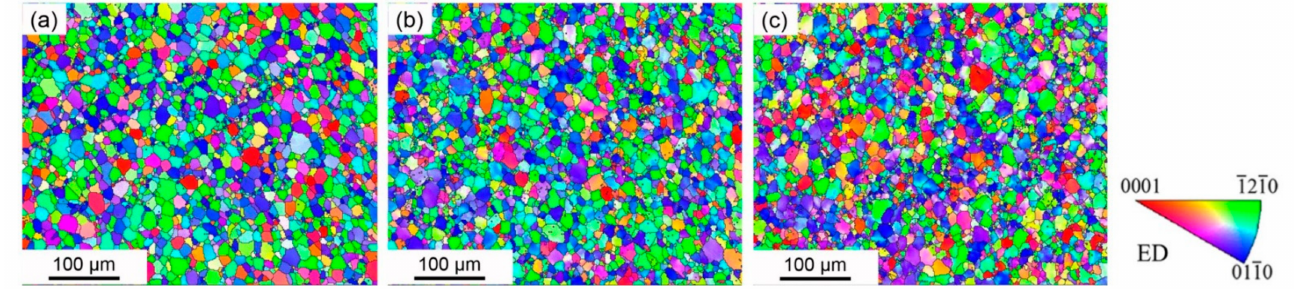
Figure 1. Inverse pole figures of the twisted samples in the edge region ( a ) PT8, ( b ) PT28, ( c ) PT51. (cid:0) (cid:1) (cid:0) (cid:1) The pole figures corresponding to ( 0001 ) , 1010 , 1011 planes are shown in Figure 2. It can be seen that after the alloy was twisted, the basal pole was rotated from uneven distribution along the radius in the starting material, reaching a concentration slightly deviating from the radius to the twist axis, and the basal pole was located at a position about 20 ◦ from the twist axis in sample PT51. It is worth noting that after the gradual change, the (cid:0) (cid:1) 1011 pole was “reset” on the twist axis. The shear deformation accommodated by <a> dislocations slipping can introduce Y fibers in the Mg alloy with the basal pole located at 60 ◦ away from the twist axis [22]. This texture with a basal pole located at about 70 ◦ away from the twist axis indicates that the activation of a large number of <a> dislocation slips and other deformation modes also have a considerable strain contribution.